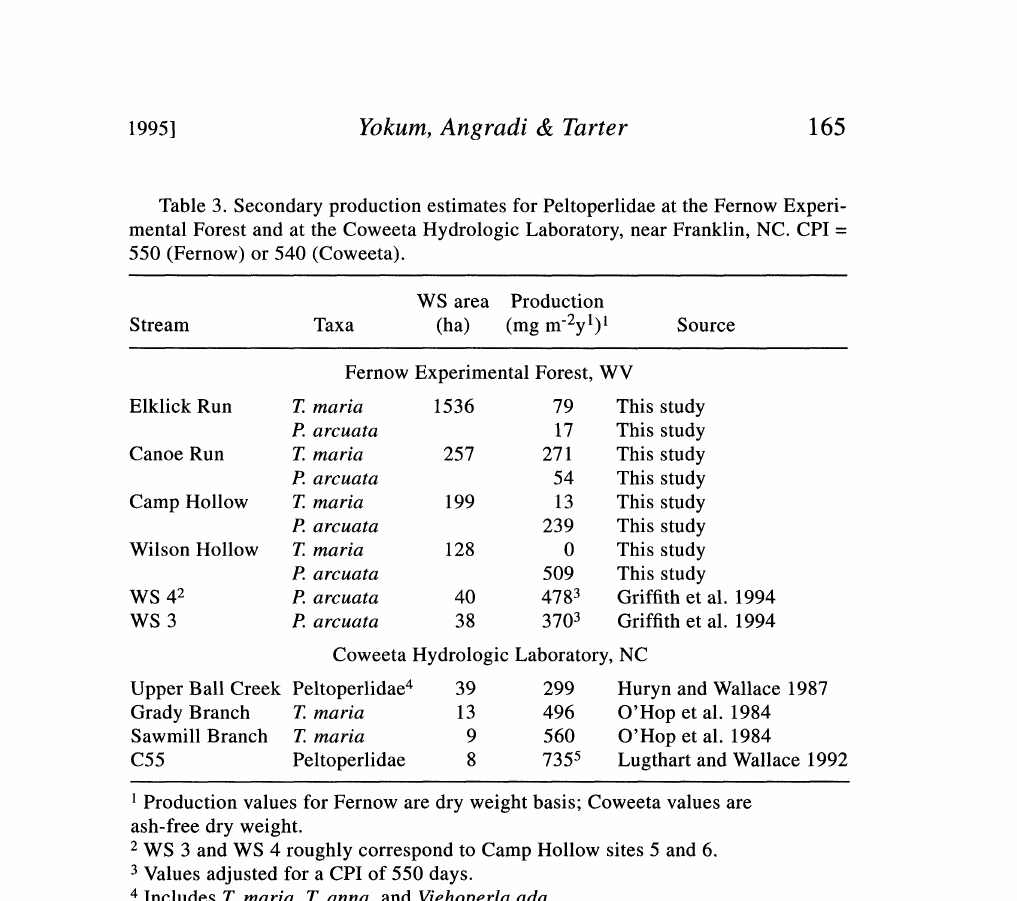
Table 3. Secondary production estimates for Peltoperlidae at the Fernow Experi- mental Forest and at the Coweeta Hydrologic Laboratory, near Franklin, NC. CPI 550 (Fernow) or 540 (Coweeta).